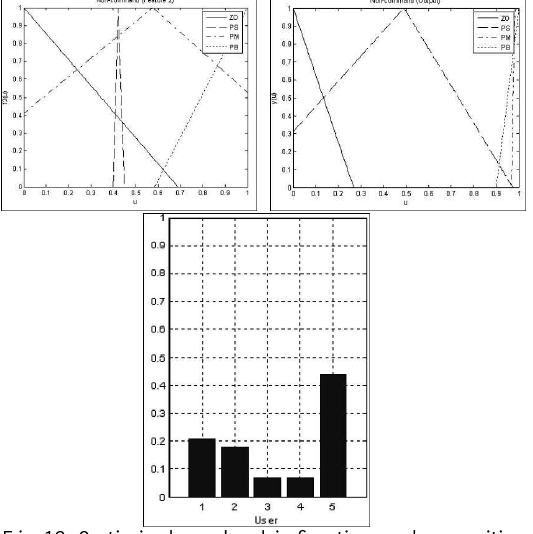
Fig. 12. Optimized membership functions and recognition error